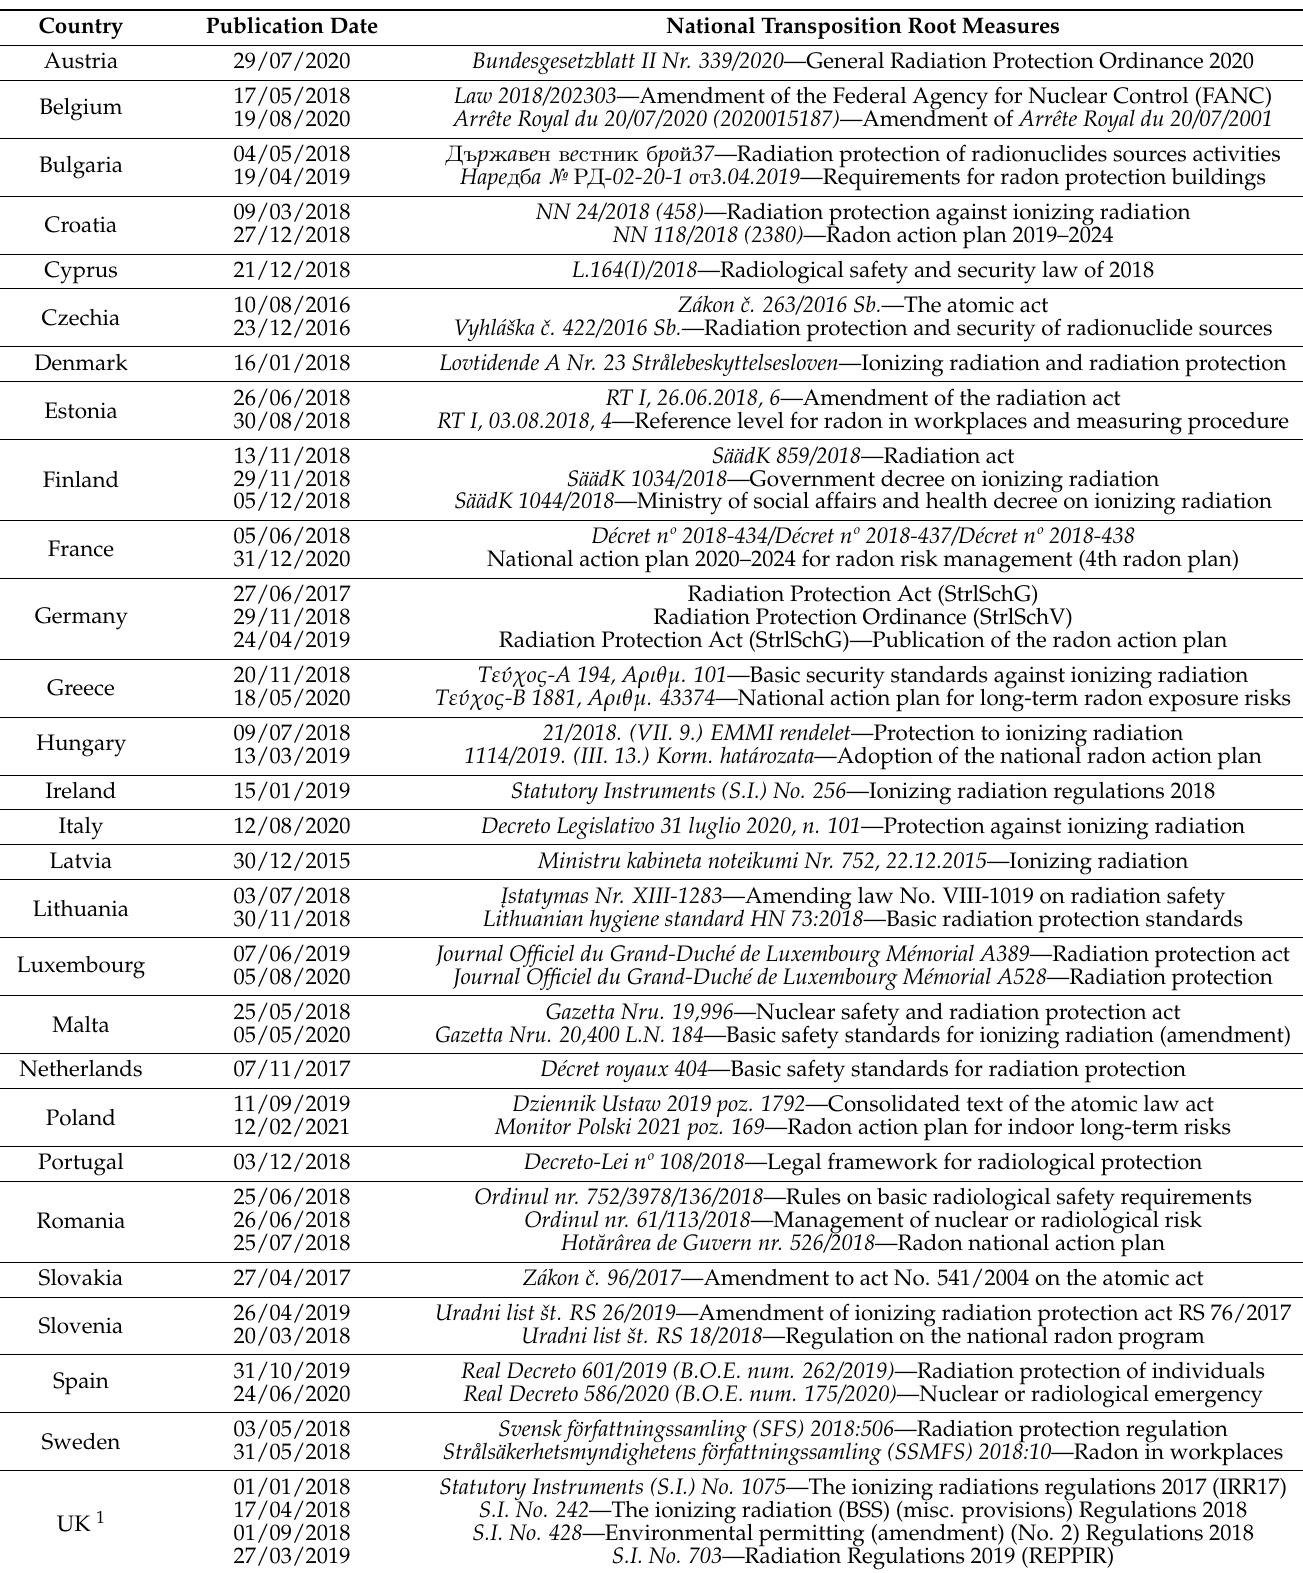
Table 1. 2013/59/EURATOM Council Directive national transposition by the Member States. Data obtained from [66].